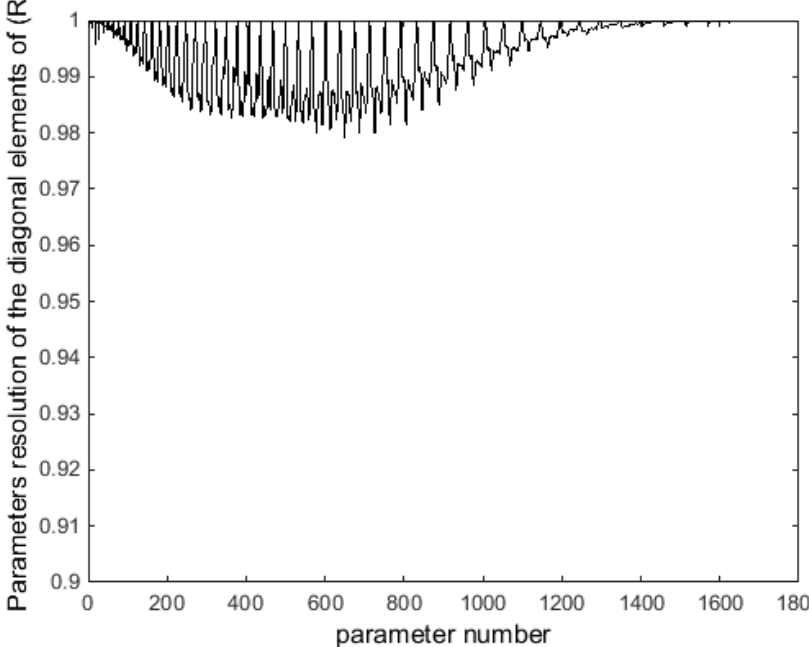
Figure 3. The diagonal elements of the resolution matrix at damping parameter α 2 = 10 − 4 with respect to the parameter numbers.